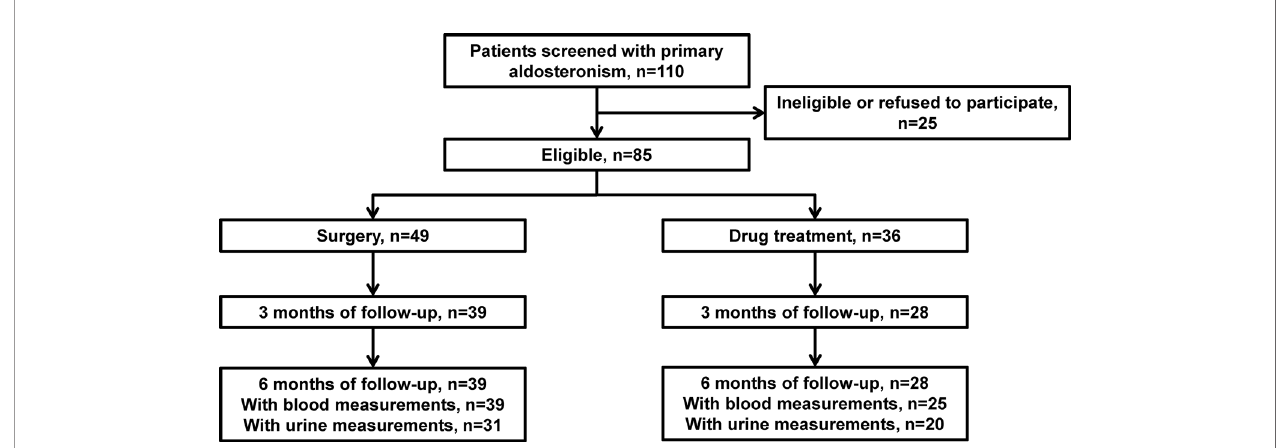
FIGURE 1 | Flow of